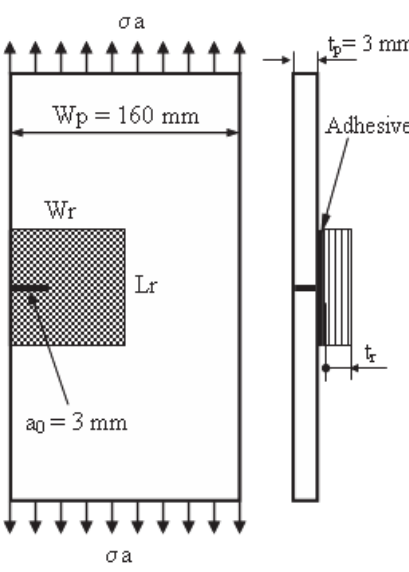
Figure 1: Edge-cracked plate with adhesively bonded composite patch